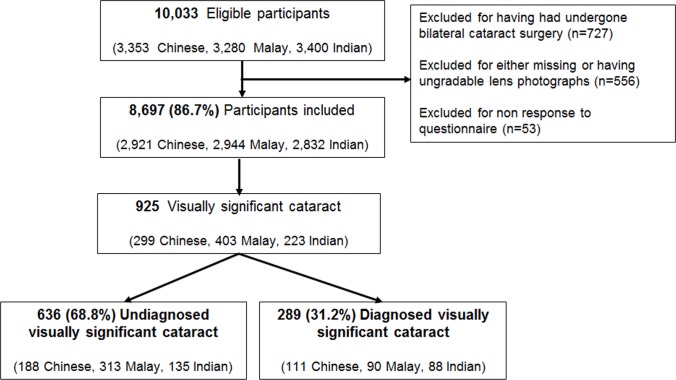
Flow chart of study participants.Among those with visually significant cataract, 68.8% (n = 636) had previously undiagnosed cataract. Unknown responses were not reported.